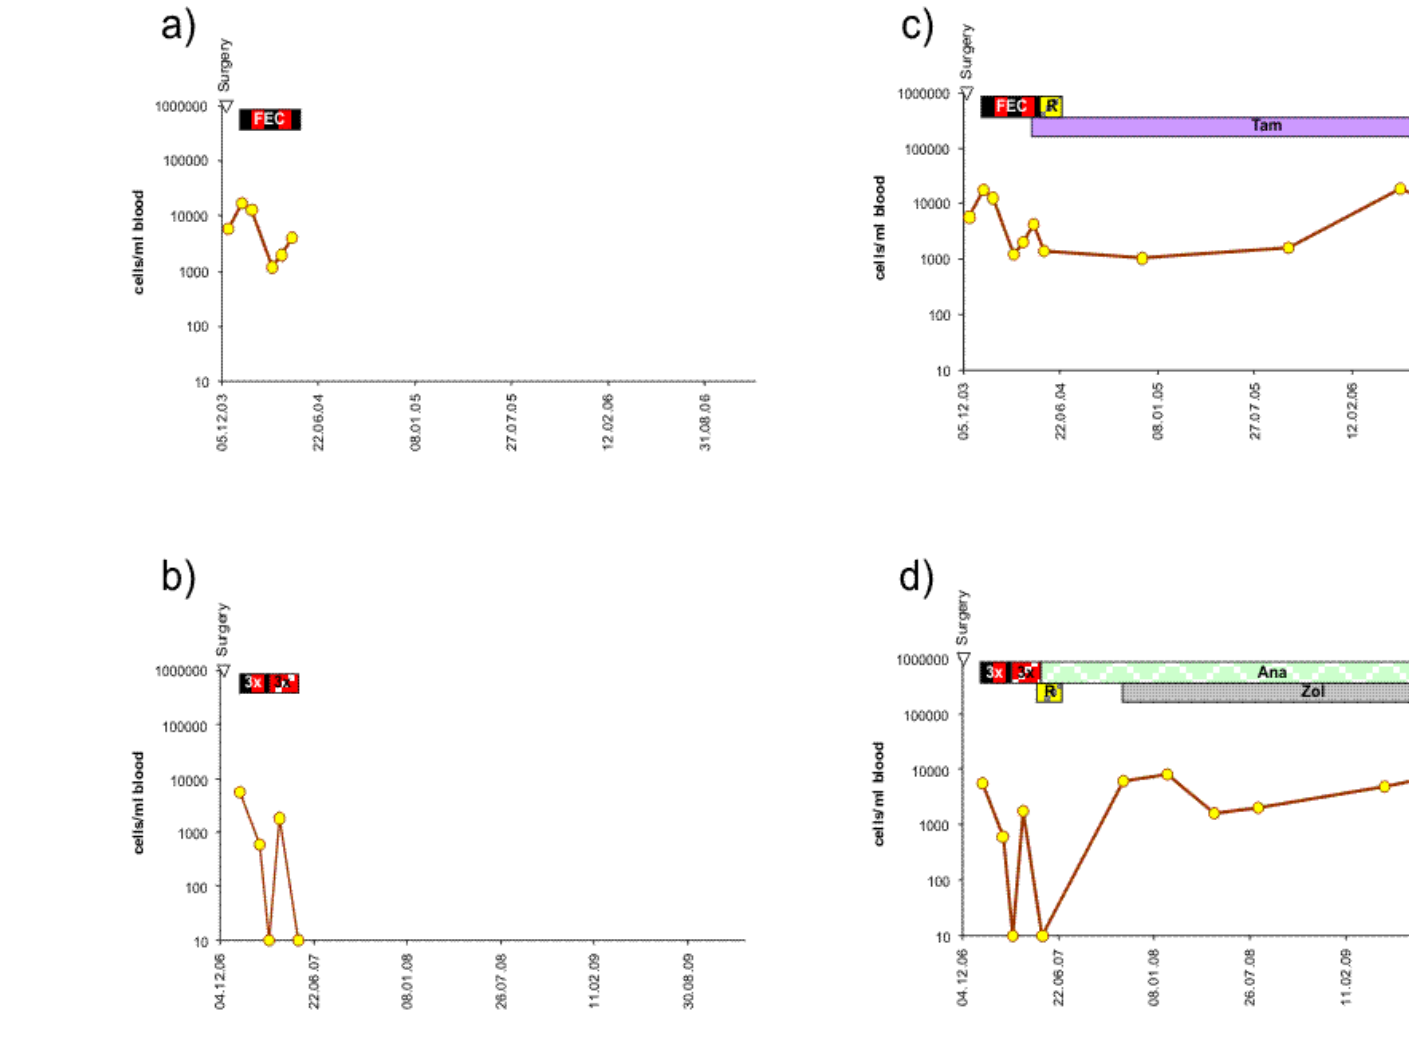
Figure 3. Typical courses of the behavior of vital cells during treatment in (a) and (b) an individual patient with HER2/neu positive tumor in complete remission and (c) and (d) with relapse. Treatment bars: as above. Ana: anastrozol; Zol: